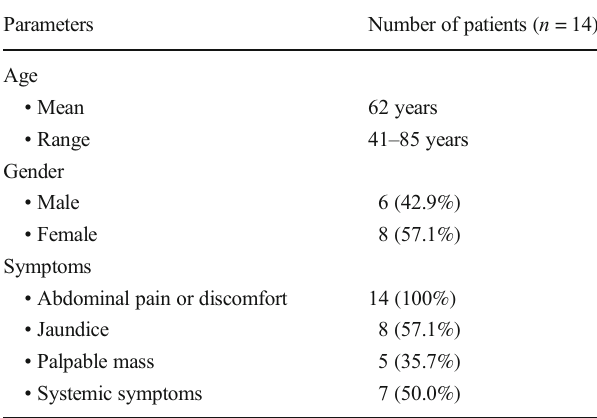
Clinical characteristics of patients affected by primary pancreatic lymphomas (PPLs) Parameters Number of patients ( n =